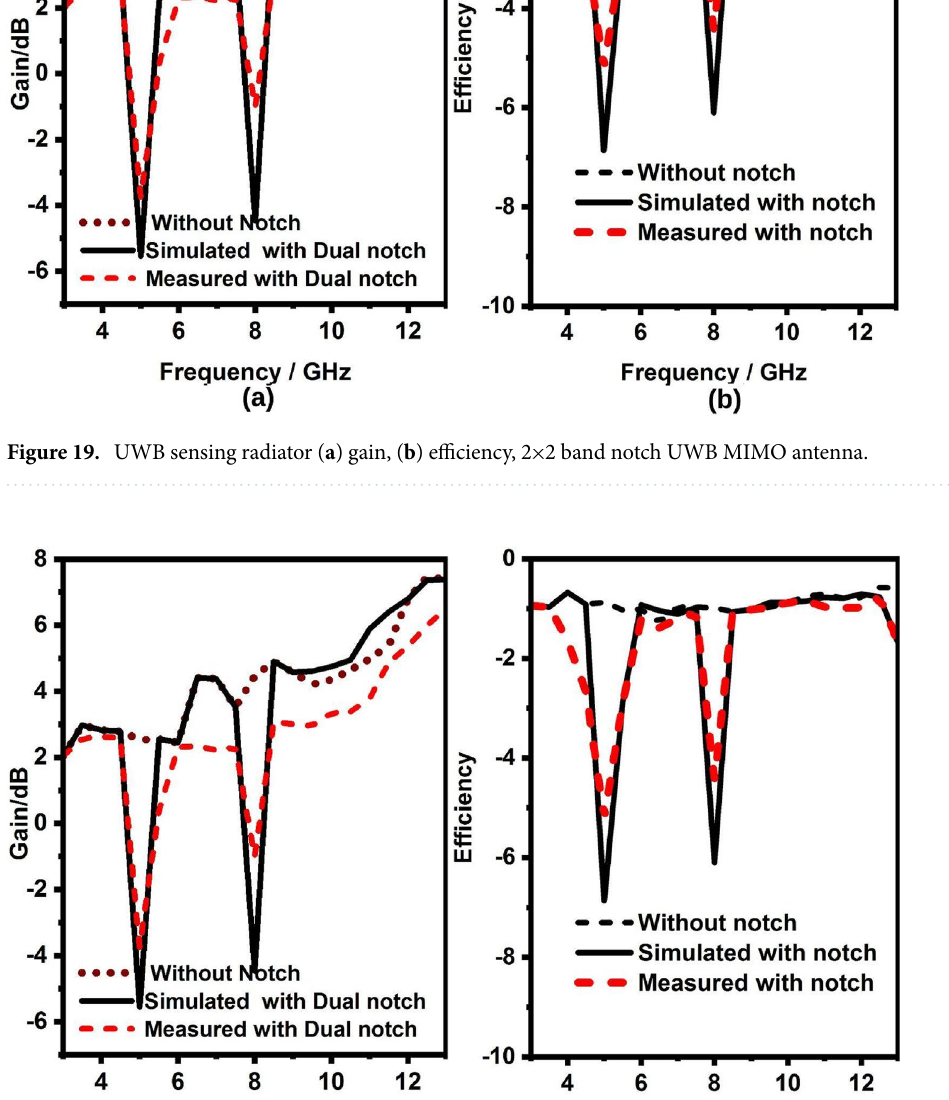
Figure 20. 2 2 band notch UWB MIMO antenna ( a ) gain, ( b ) ×